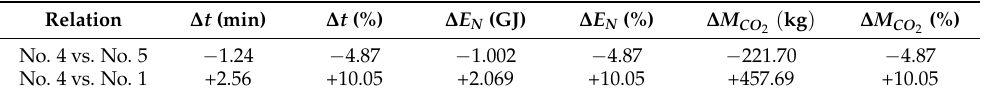
Table 7. The numerical and percentage difference between the flight duration, the energy consump- tion, and the total amount of CO 2 emitted on the most sustainable trajectory (No. 4). in relation to the reference trajectory (No. 5) and to another determined trajectory No. 1 (trajectory No. 4 = 100%) on the Copenhagen–Gdansk